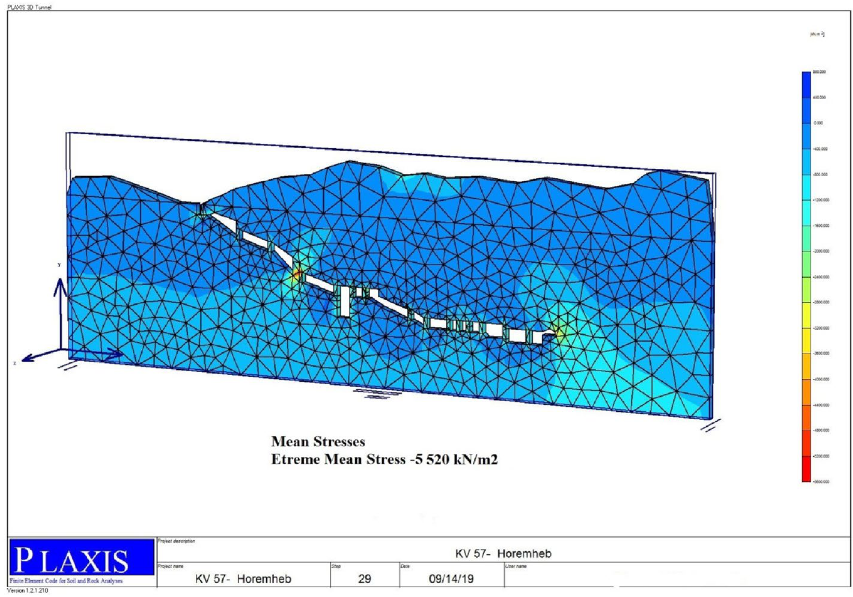
Fig. 4. Mean stresses for the supported rock pillars and sidewalls in KV57, the extreme value is 5.52 kN/m